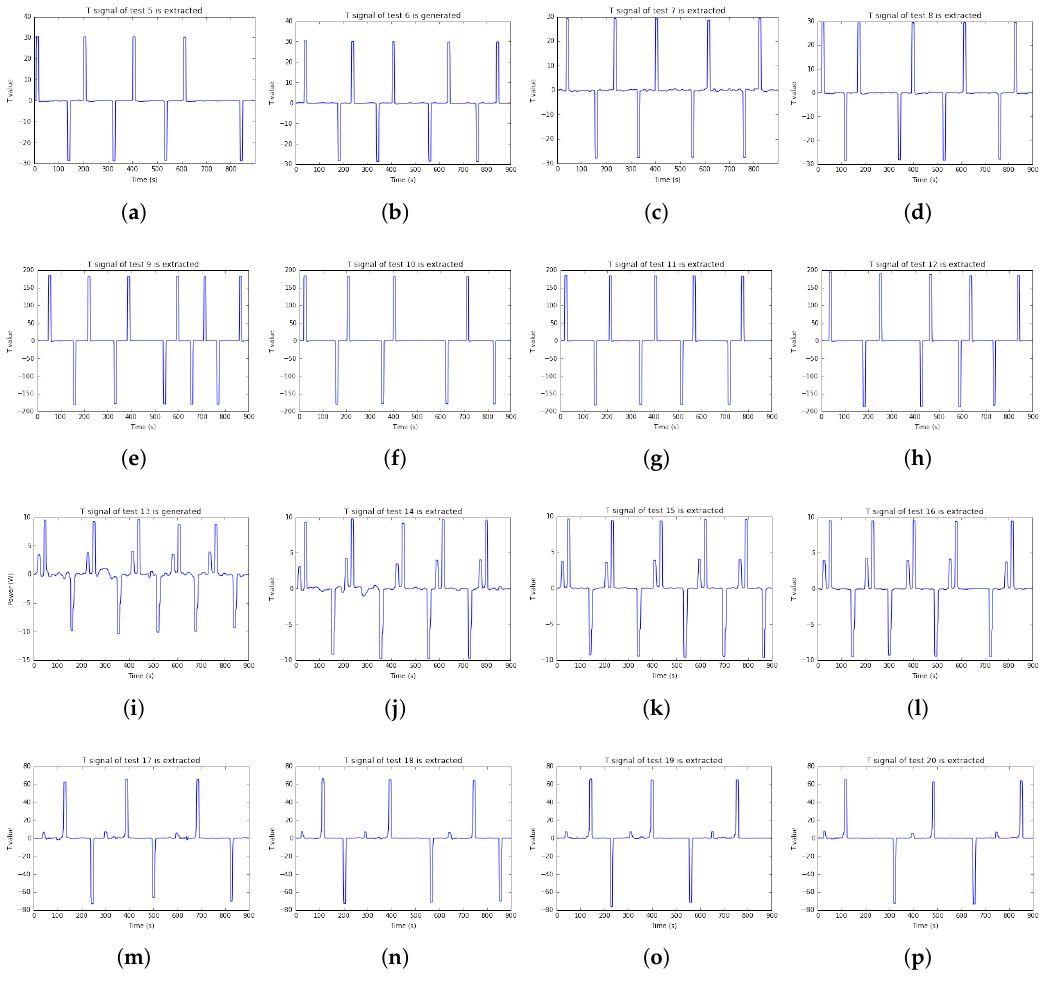
Figure A2. Transient T signals of test 5 to test 20